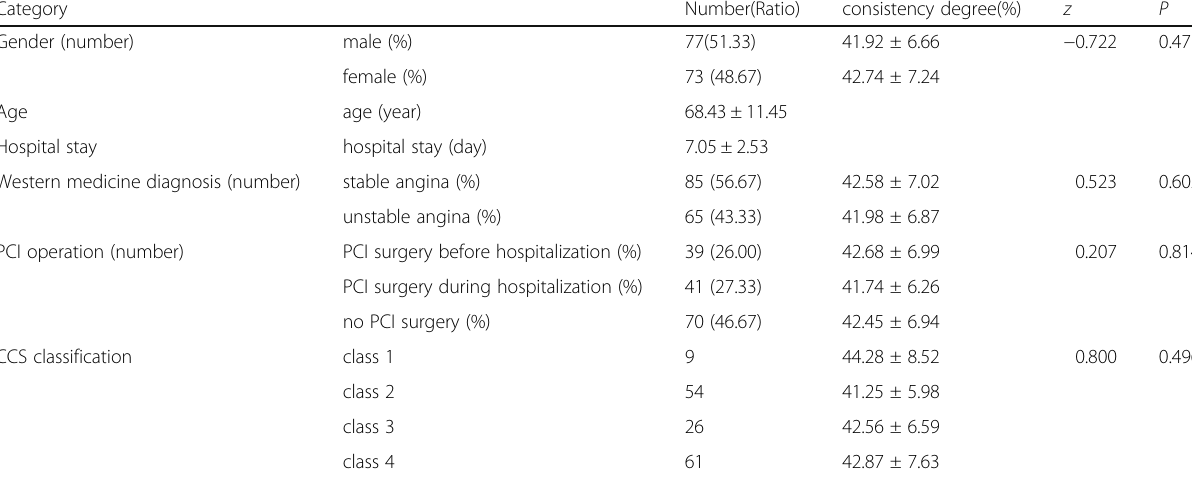
Table 4 Basic biographical information for the 150 angina inpatients and overall consistency comparison Category Gender (number)